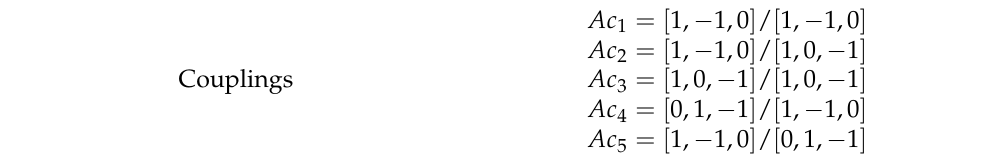
Figure 6. Frequency response of PLC channel for each coupling A c proposed in the study case. Table 1. Coupling schemes.